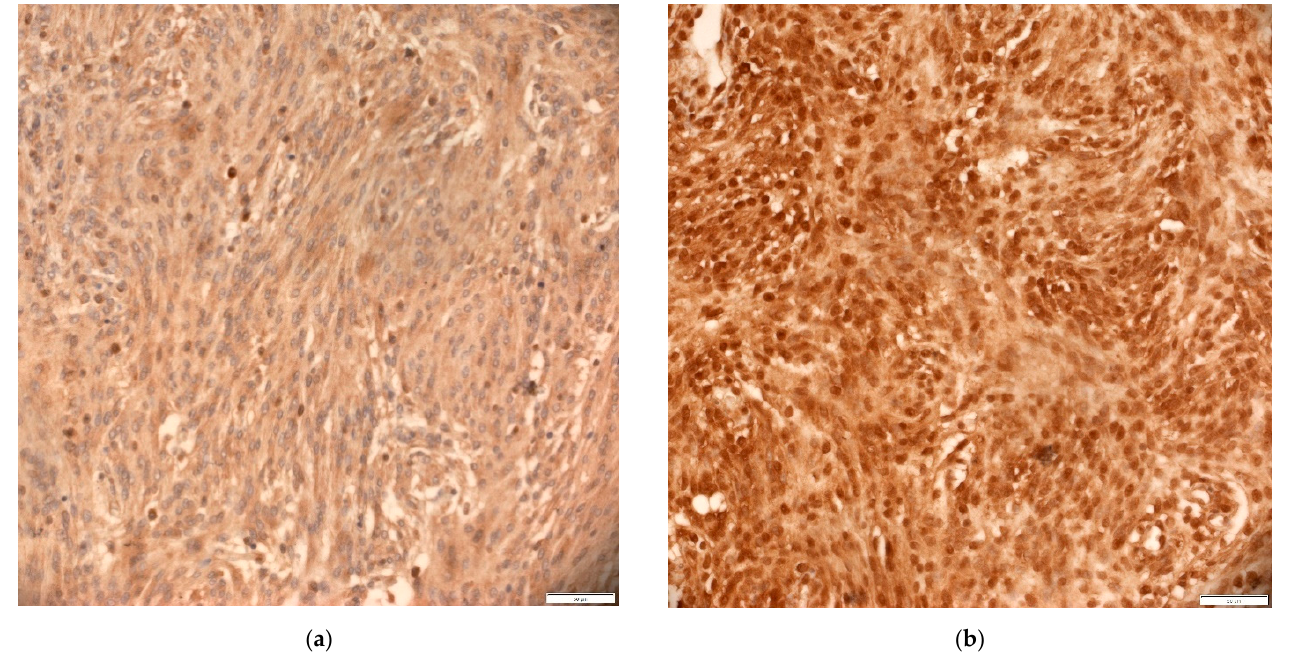
Figure 4. Immunohistochemical staining of meningiomas with polyclonal SNAIL and SLUG antibody at 200 × magnification. ( a ) sample with low nuclei staining intensity (<50% of nuclei) and ( b ) sample with strong nuclei staining intensity ( ≥ 50% of nuclei). Scale bars: 50 μ m.